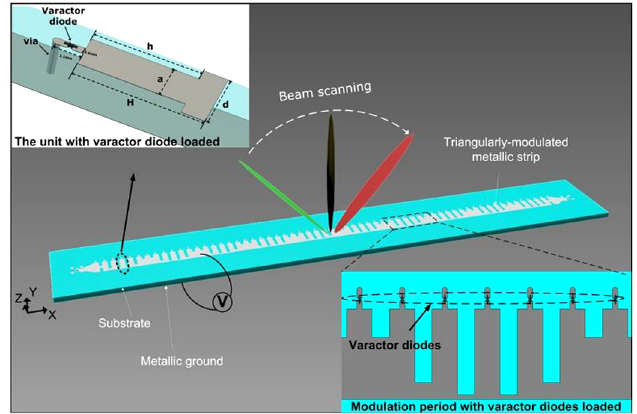
Fig. 3. Schematic of a leaky-wave antenna loaded with varactor diodes [19].